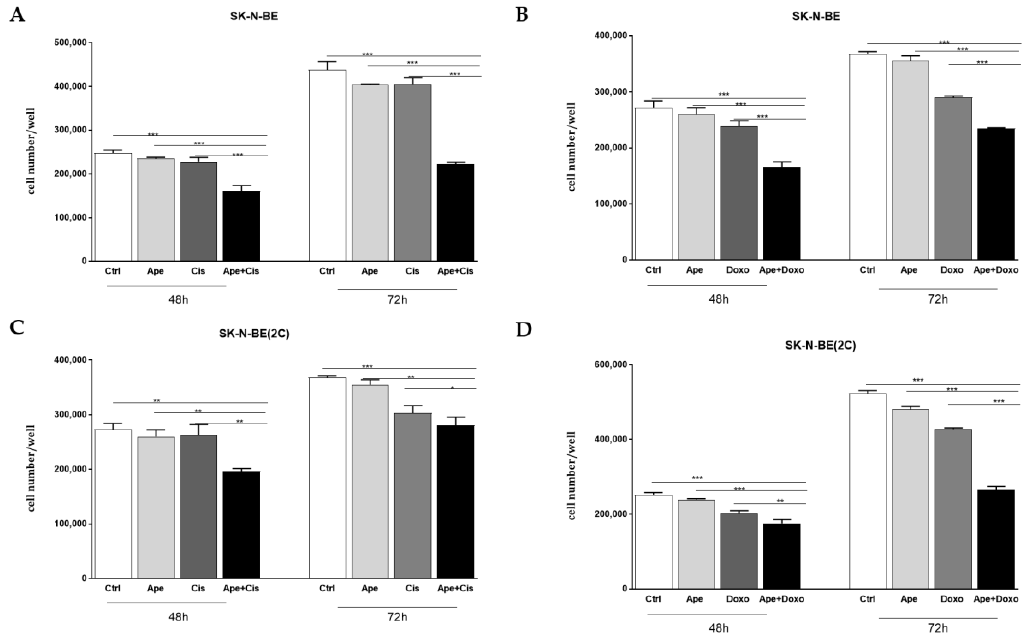
Figure 6. Analysis of cell proliferation by MTT assay after 48 and 72 h of co-treatment with APE and cisplatin (Cis) in SK-N-BE ( A ) and SK-N-BE(2C) ( C ) cells treated with 3 µ M APE, 3 µ M Cis and 3 µ M APE + 3 µ M Cis). (* p < 0.05; ** p < 0.01; *** p < 0.001; Ape + Cis vs. Ctrl; Ape + Cis vs. APE; Ape + Cis vs. Cis). Analysis of cell proliferation by MTT assay after 48 and 72 h of co-treatment with APE and doxorubicin (Doxo) in SK-N-BE ( B ) and SK-N-BE(2C) cells ( D ) treated with 3 µ M APE, 0.01 µ M Doxo and 3 µM APE + 0.01 µM Doxo. (** p <0.01; *** p < 0.001; Ape + Doxo vs. Ctrl; Ape + Doxo vs. APE;